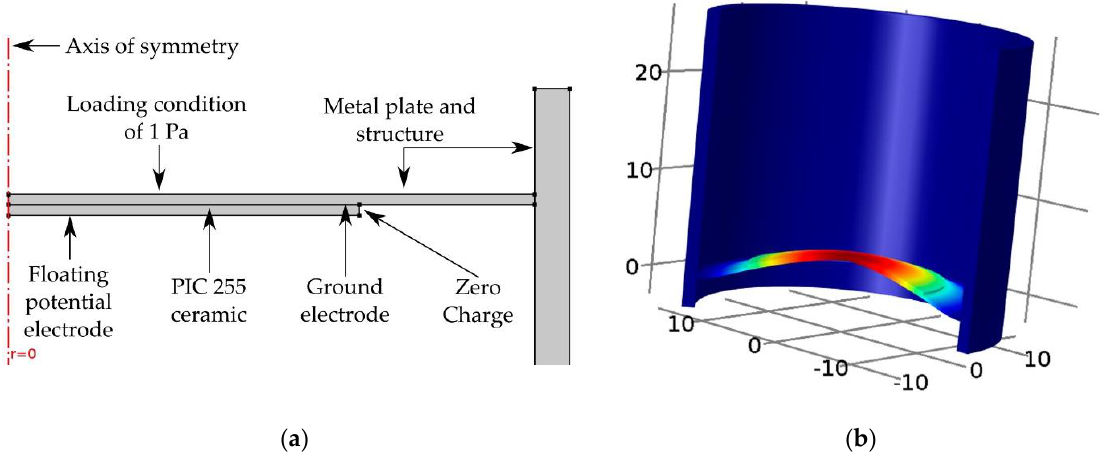
Figure 4. ( a ) Model for the simulation of sensor sensitivity; ( b ) Simulated first flexural mode of the front plate with the piezoelectric ceramic attached.